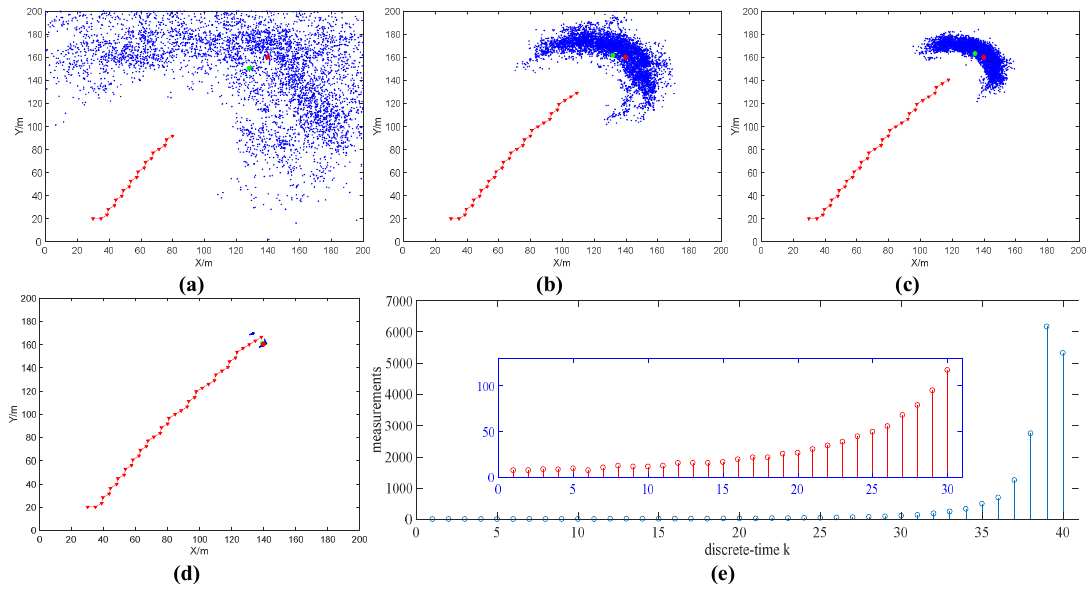
Figure 3 . The estimation results of radioactive sources when the angular velocity  = 0.7 rad/s ( a ) Figure 3. The estimation results of radioactive sources when the angular velocity ω = 0.7 rad/s ( a )  = 20 , ( b )  = 30 , ( c )  = 33 and ( d )  = 40 . ( e ) Shows the measured value   obtained during k = 20, ( b ) k = 30, ( c ) k = 33 and ( d ) k = 40. ( e ) Shows the measured value z k obtained during the the search of the radioactive source. search of the radioactive source. Table 2. Errors of radioactive source estimates at di ff erent angular Table 2. Errors of radioactive source estimates at different angular velocities.